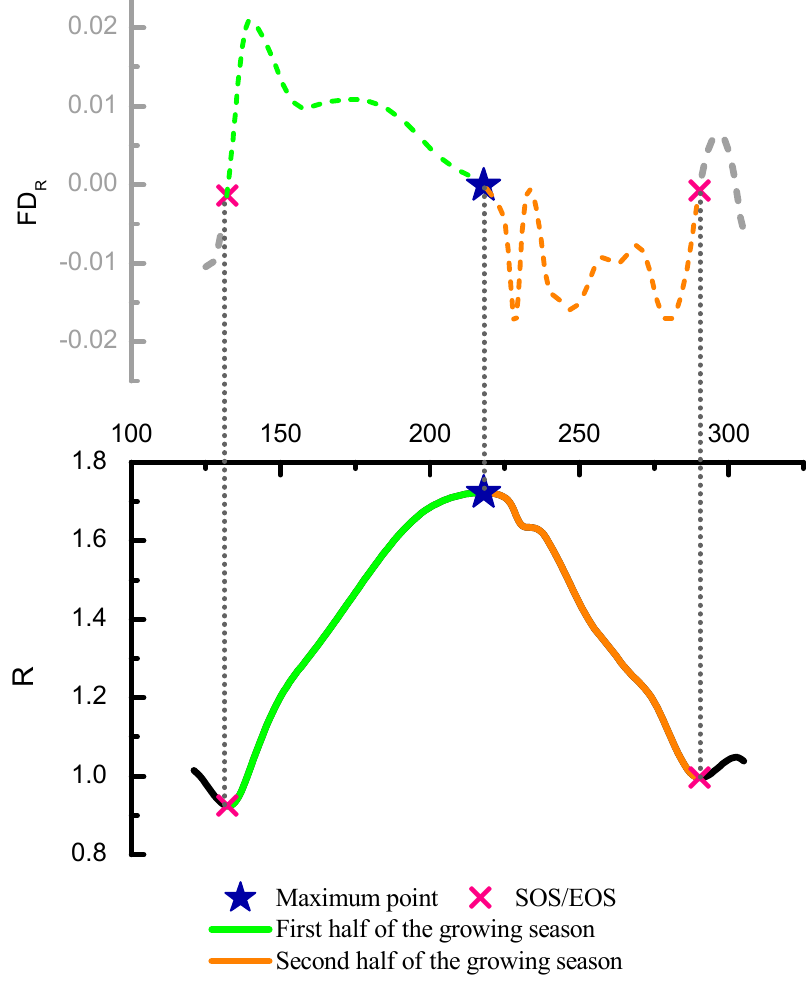
Figure 6. R and FD R during the rice growing period. The maximum point divides the growth process of rice into two parts: the first half of the rice growth period and the second half of the rice growth period.